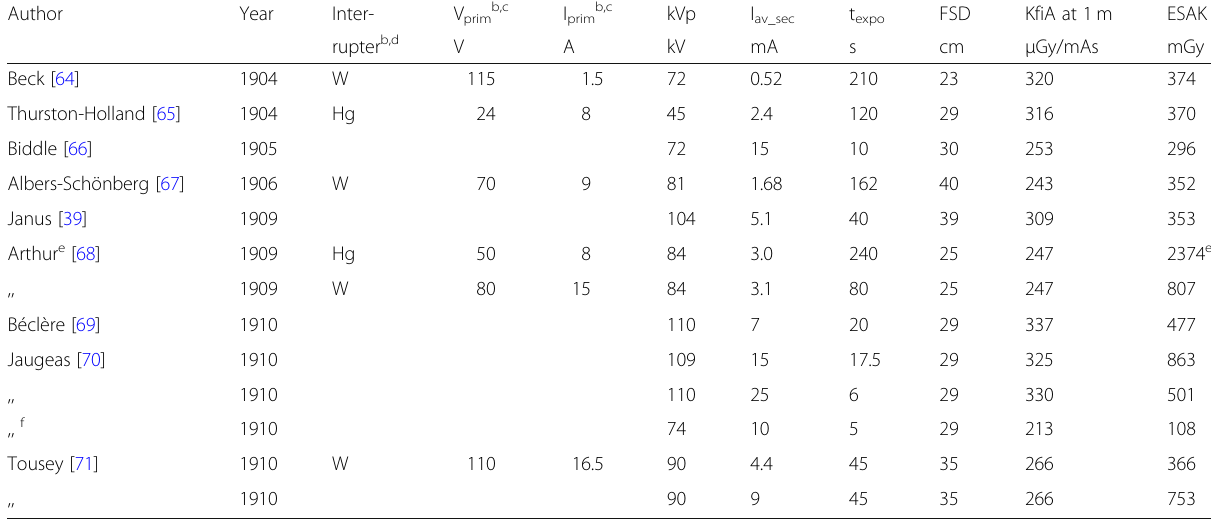
Table 7 Some exposure parameters from the period 1900 – 1910 and the corresponding ESAK a